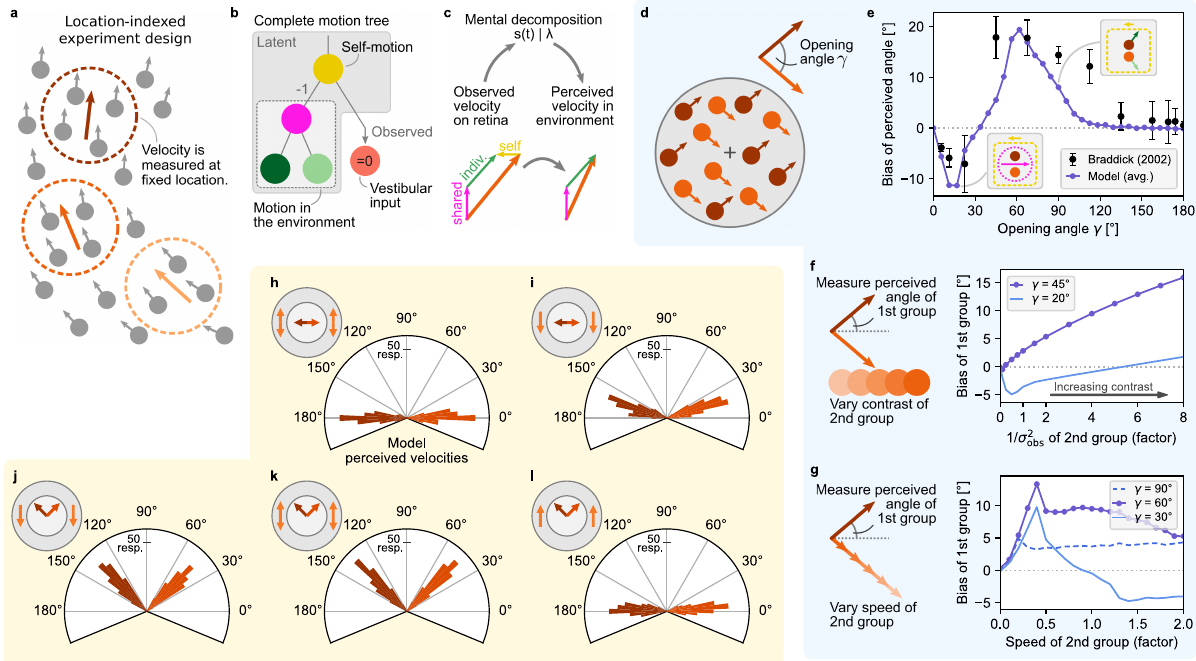
Fig. 4 | Hierarchical inference explains motion illusions in location-indexed experiments. a In location-indexed experiments, motion fl ow is presented at sta- tionary spatial locations. b Considered latent motion components. Self-motion, which affects all retinal velocities in the opposite direction ( − 1) integrates both visual input and a vestibular signal (here: zero + noise). c Perceived object velo- cities, relative to the environment, are the sum of all inferred motion components excludingself-motion. d Inmotiondirectionrepulsionexperiments, twogroupsof dots move at constant velocity with opening angle γ . e The direction in which human perception of the opening angle is biased depends on the true opening angle. Black dots: human data, reproduced from ref. 36, error bars denote S.E. of themeanacrosssubjects; n =3subjects,80trialsperangleandsubject.Purpleline: model percept. Insets: the model ’ s inferred motion decomposition. f Varying the contrast of one dot group modulates the biased percept of the angle of the other group. Purple: model percept for γ =45°, qualitatively matching data from ref. 37. Blue: predicted inversion of the bias for smaller opening angles. g Same as panel f ,butforvaryingthespeedofthesecondgroup.Purple:modelperceptfor γ =60°,